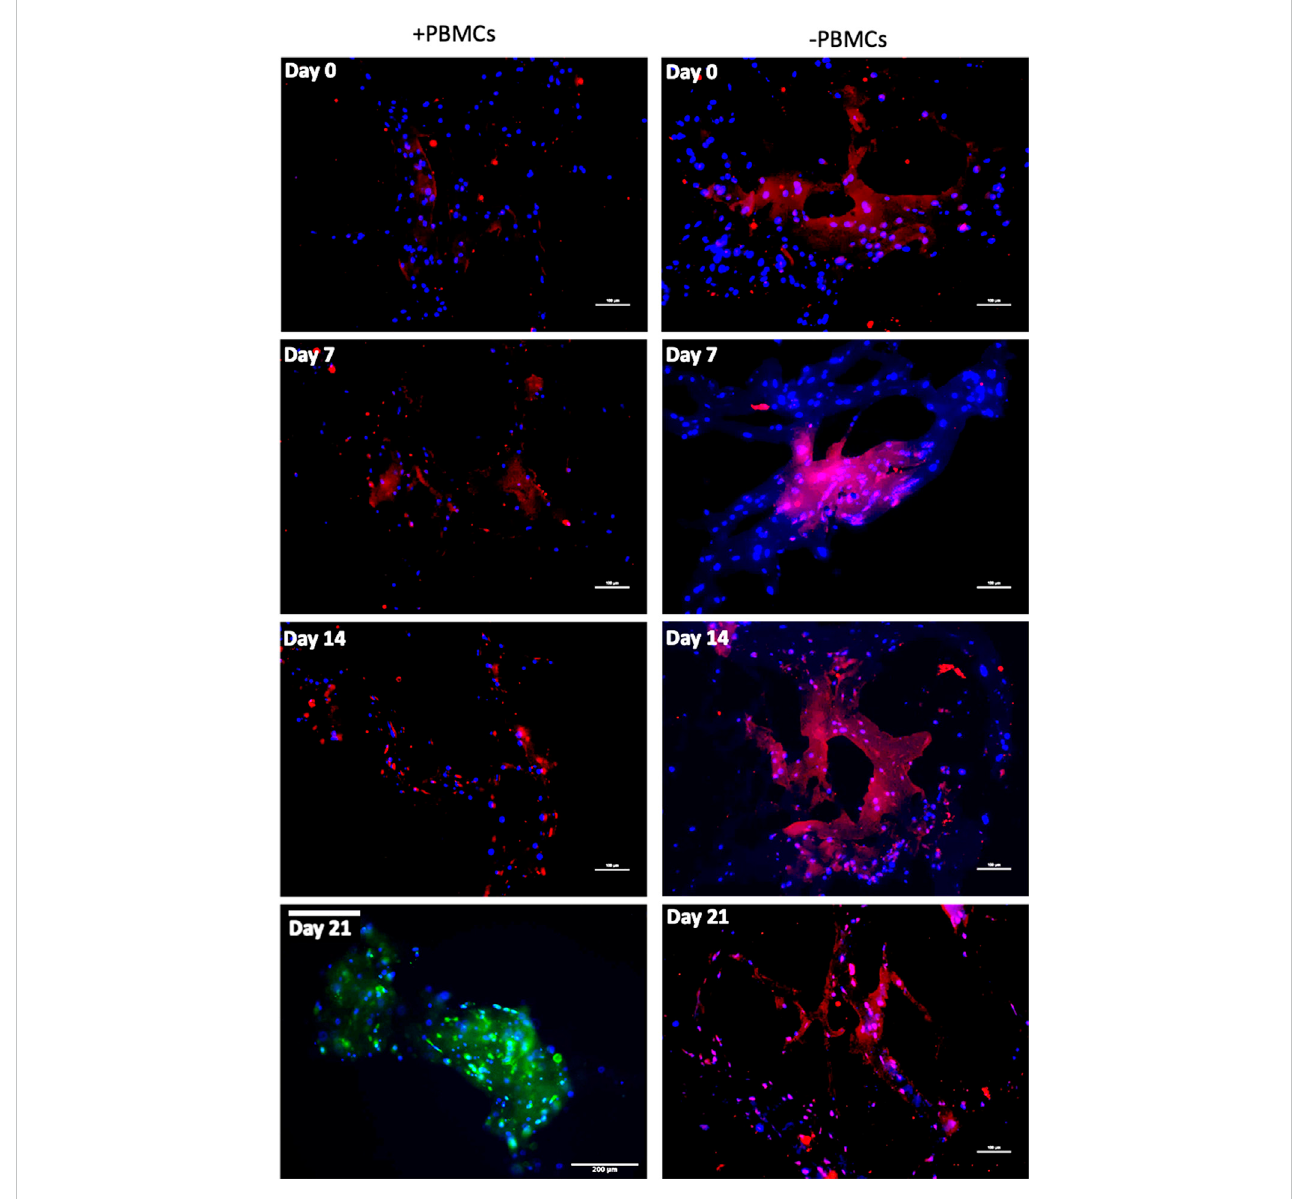
FIGURE 6 Immuno fl uorescence images of 3D fi brin scaffold for Desmin and MYH2 obtained by IF assay performed at day 7, 14 and 21 of culture. Desmin was stained in red and MYH2 in green; scaffolds embedded with h BM-MSCs- h SkMs-PBMCs (left column) and scaffolds embedded with h BM-MSCs- h SkMs (right column) are shown. MYH2 was not detected. All images were captured using ×20 magni fi cation, scale bar: 200